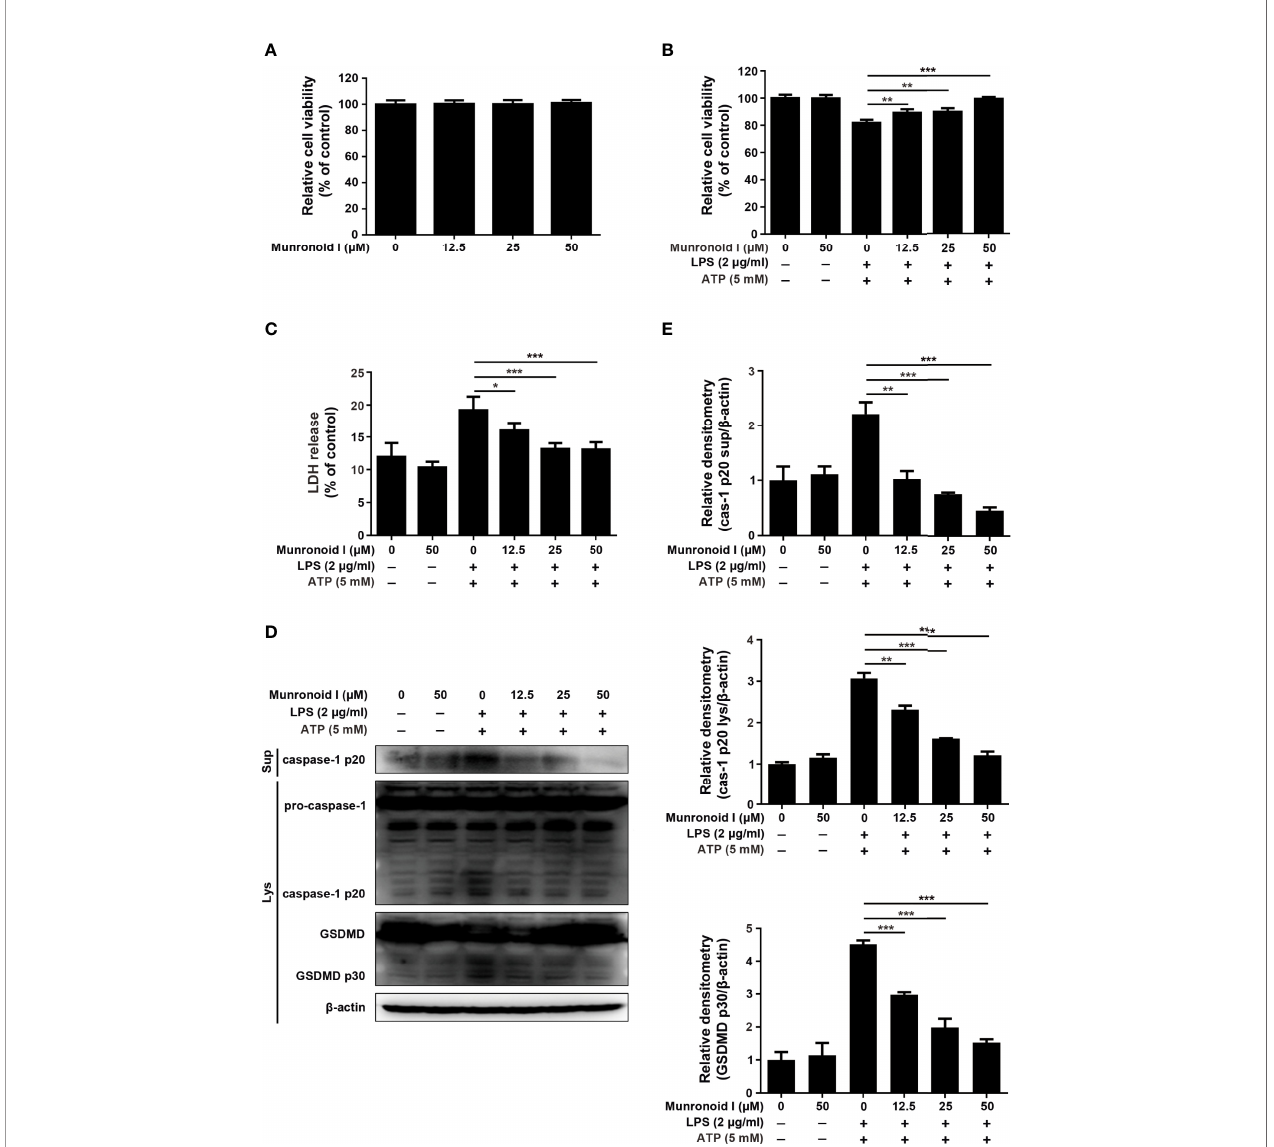
FIGURE 5 | Munronoid I suppresses LPS/ATP-induced the activation of canonical pyroptosis pathway in MODE-K cells. (A) MODE-K cells were treated with DMSO or different concentrations of Munronoid I (12.5 m M, 25 m M, 50 m M) for 24 h, the cell viability was determined by CCK-8 assay. Results presented as mean ± SD (n=5). (B – D) MODE-K cells were pretreated with DMSO or Munronoid I (12.5 m M, 25 m M, 50 m M) for 2 h, following LPS (2 m g/ml) stimulation for 4 h, and then treated ATP (5 mM) for 30 min. And the cells viability was detected by CCK-8 assay (B) . The supernatants were analyzed by LDH assay (C) . And caspase-1 and GSDMD were detected by Western blot (D) . Relative densitometry analyzed by Image J (E) . Data in A, B, C, and E presented as the mean ± SD of three independent experiments. *p<0.05, **p<0.01,